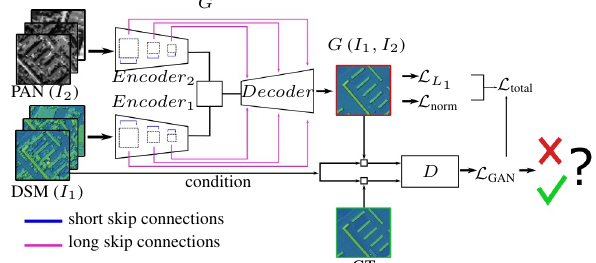
Figure 1. Schematic overview of the proposed architecture for building shape optimization in low-quality photogrammetric DSMs. The generative module G is represented by an encoder-decoder network which consists of two separate encoders, processing the depth and intensity information simultaneously, and a single decoder